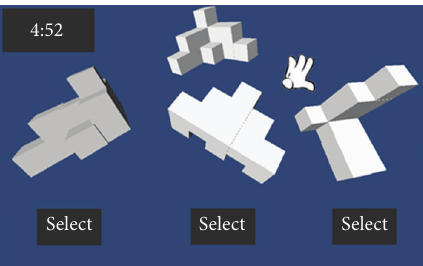
Figure 17: Another illustration of geometric game.